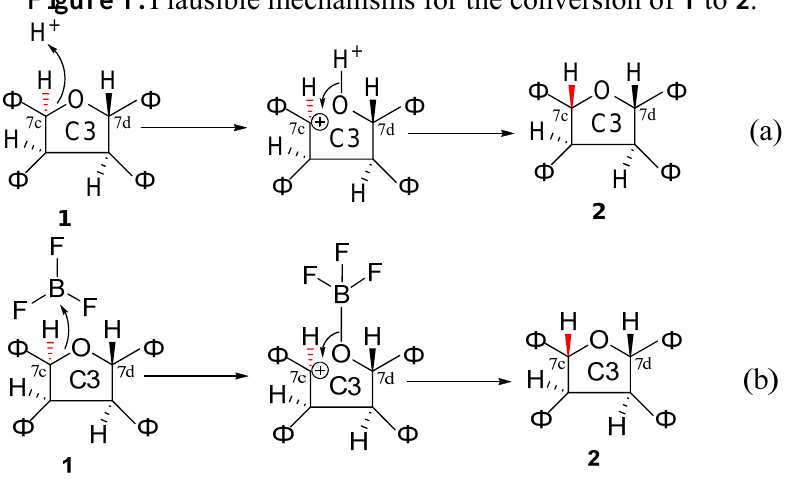
Figure 1. Plausible mechanisms for the conversion of 1 to 2